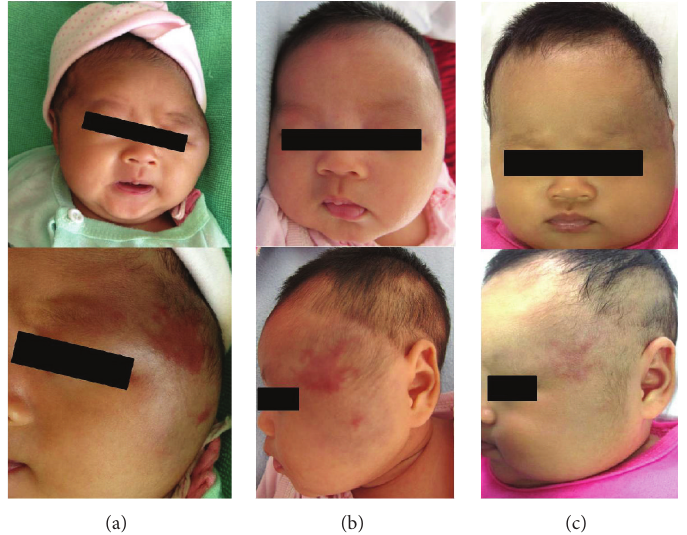
Figure 1: (a) Showing the patient at 5 weeks of age, before treatment with propranolol (at a dose of 2 mg per kilogram of body weight per day). (b) Showing the patient at 3 weeks after the initiation of propranolol with some degree of regression of primary lesion. (c) Showing the patient at 9 months of age (8 months after the initiation of propranolol treatment) with regression of primary lesion.